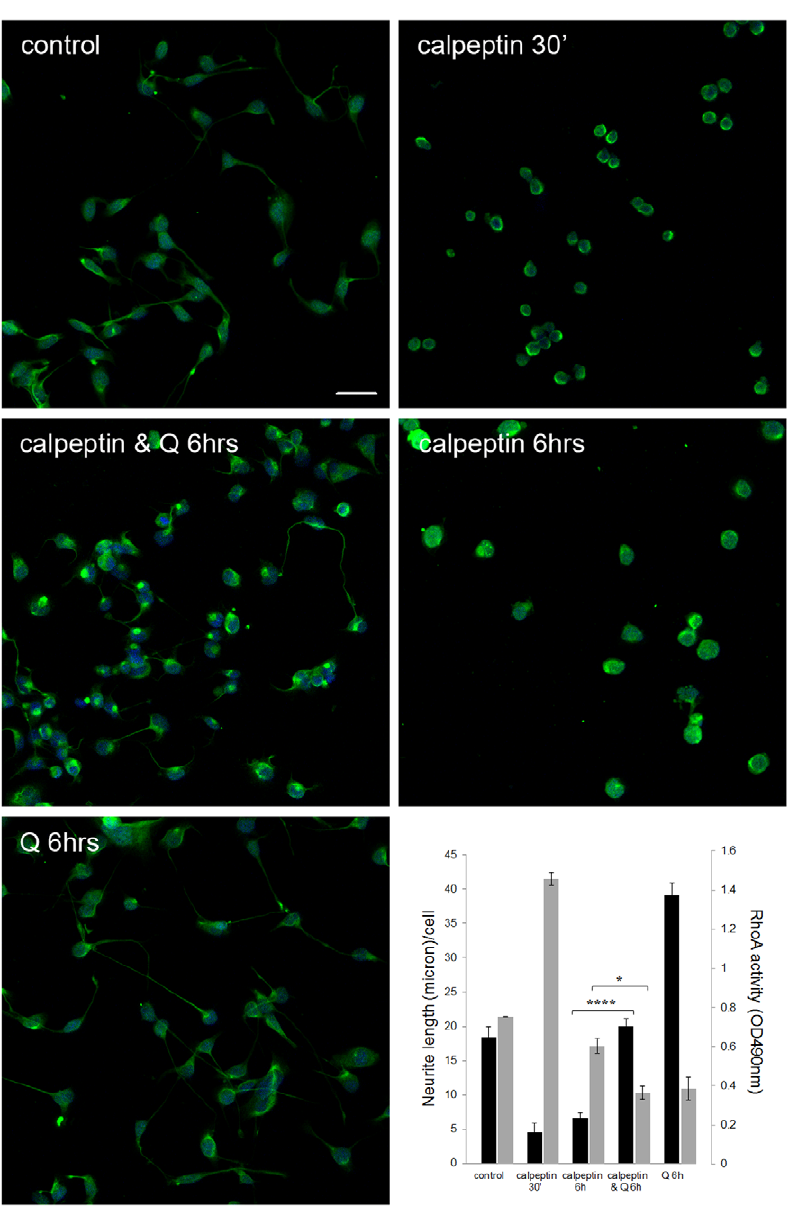
Figure 6. Isoquercitrin is able to restore the neural phenotype in calpeptin stimulated cells. The fluorescence images show 6 hr cultures stained with anti-neurofilament antibody. Green=neurofilament protein, blue=nuclei. Scale bar=50 micron. Bottom right , The double y-axis graph shows: 1) the neurite length (micron)/cell (black bars) measured on the fluorescence images as described in M&M (n=10 images, one-way ANOVA ****p , 0.0001); 2) RhoA activation state (grey bars) evaluated through the Rho G LISA assay (n=3, one-way ANOVA *p , 0.05). Data are shown as means 6 s.e.m.